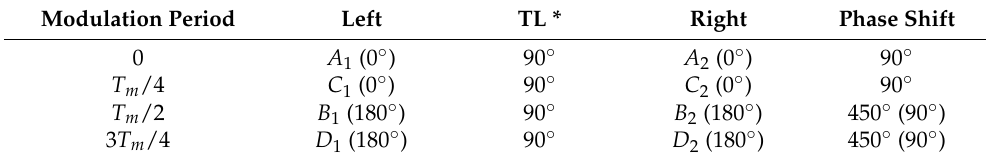
Table 2. Phase shift in forward direction.